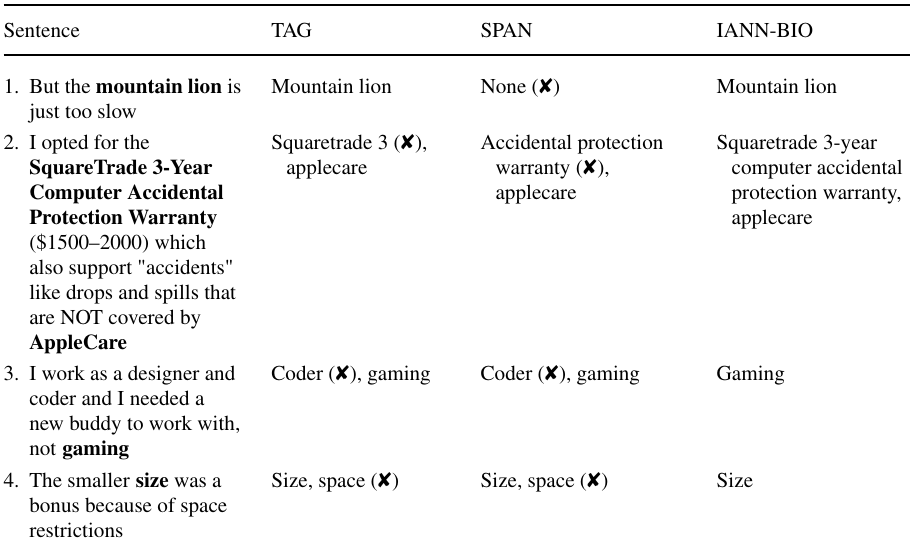
Table 7 The predictions of different methods Sentence